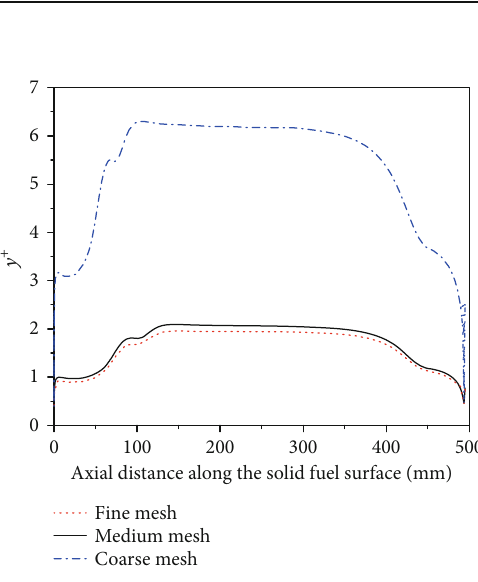
Figure 2: y + of the validation